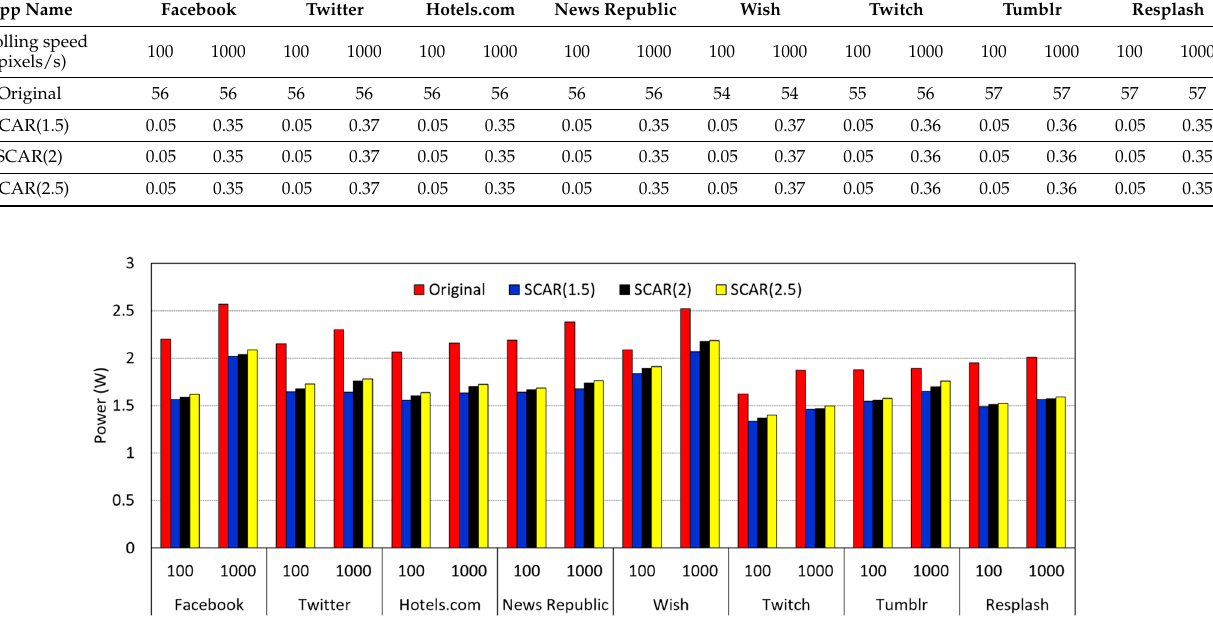
Figure 8. Power consumption for various apps and scrolling speeds.